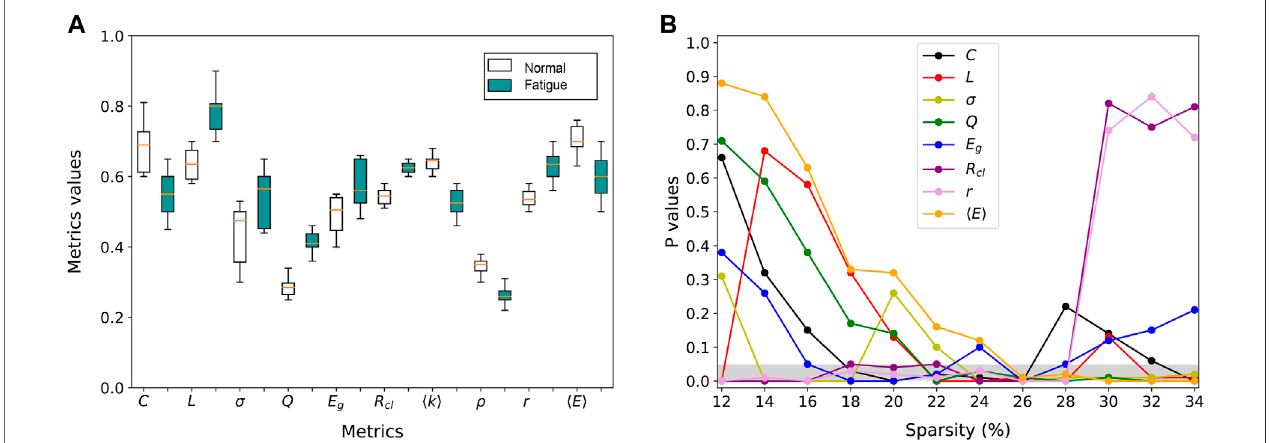
FIGURE 4 | Statistically signi fi cant difference of metrics between fatigued and healthy groups. (A) Inter-group differences of global metrics in the individual layer of F3 channel. (B) Statistical signi fi cance of the inter-group difference of global metrics as a function of network sparsity.